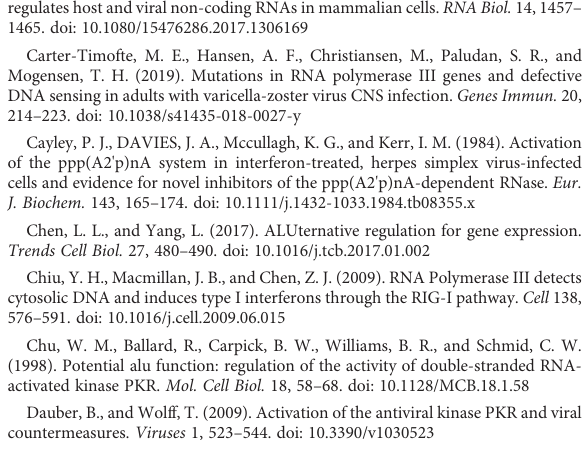
Silencing of components of antiviral defense affects viral replication and DEGs. (A) Experimental design for the study created partially on Biorender.com. (B) Number of differentially expressed genes (DEG) detected following VZV infection in the presence and absence of Pol III component BRF1. (C) Heatmap depicting the 28 DEGs detected in untransfected WT A549 cells with VZV infection. Boxed genes are differentially expressed in siBRF1+ transfected cells relative to untransfected counterparts. (D) Relative abundance of VZV transcripts detected in untransfected and in siBRF1-transfected cell lines by RT- qPCR. P values determined by 1-way ANOVA with * P <0.05, ** P < 0.01